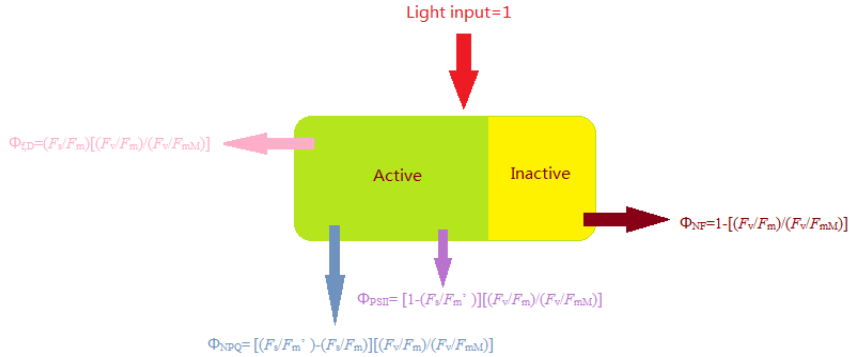
Figure 1. Energy allocation pathways of photosystem II (PSII): proportion of light energy used in the quantum yield of PSII photochemistry ( Φ PSII ), xanthophyll-mediated thermal dissipation ( Φ NPQ ), quantum yield used in thermal dissipation in non-functional PSII ( Φ NF ), and quantum yield of fluorescent and heat energy dissipation ( Φ f,D ).